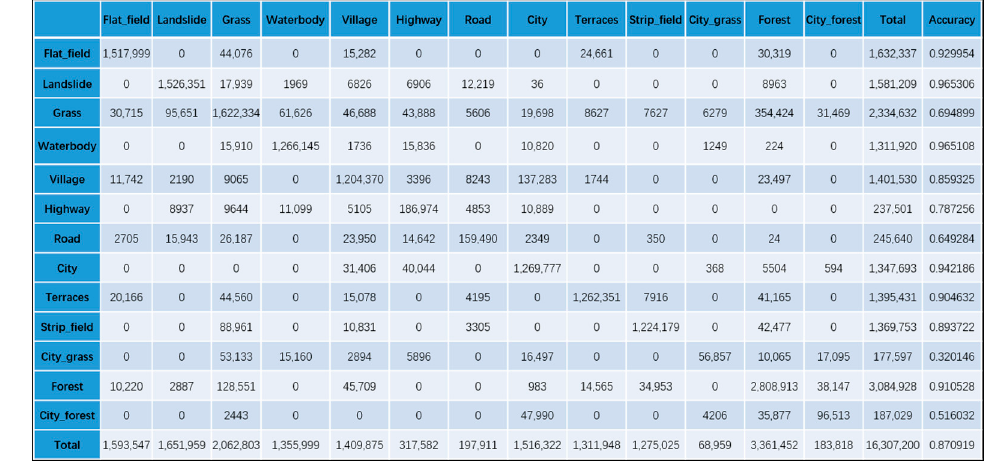
Sensors 2021 , 21 , x FOR PEER REVIEW Figure 17. The pixel-based confusion matrix of the Cluster-GCN model. Figure 17. The pixel-based confusion matrix of the Cluster-GCN model.